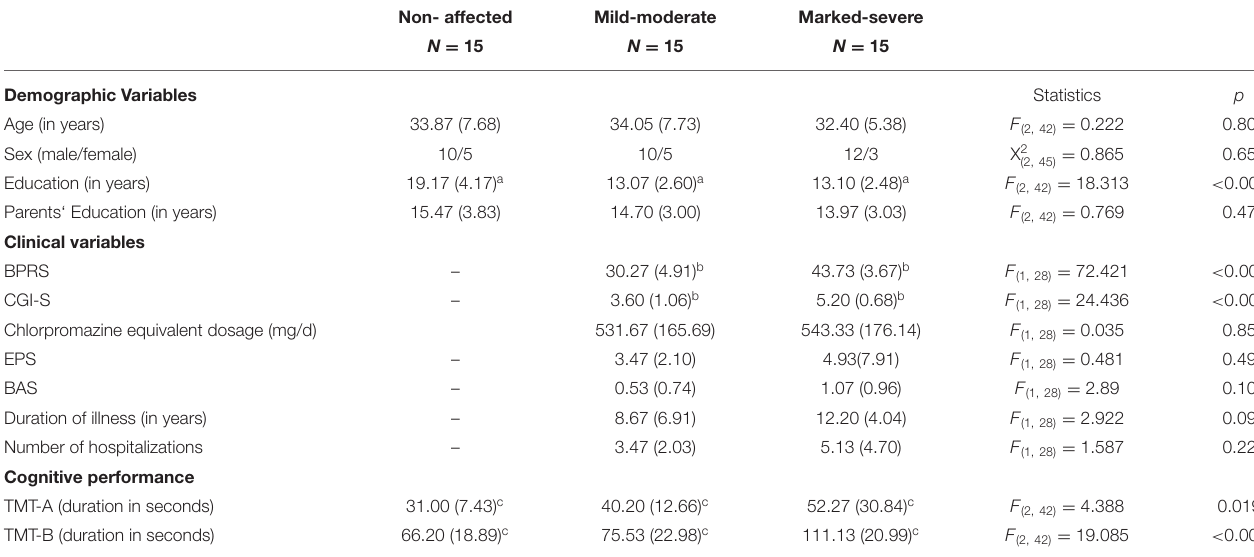
TABLE 1 | Demographic and clinical characteristics of the sample.